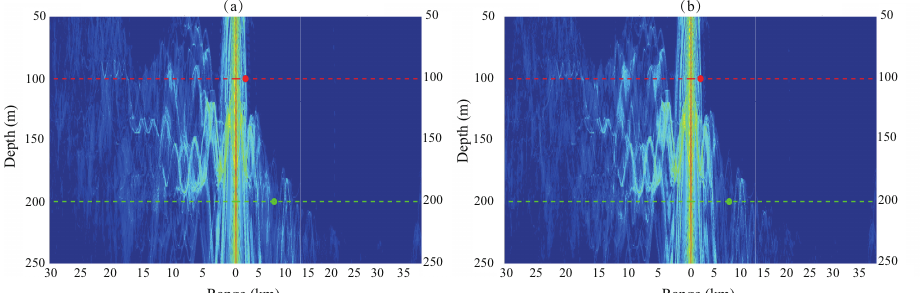
Figure 22. 2D simulation of sound pressure transmission loss at the frequency of ( a ) 120 Hz and ( b ) 200